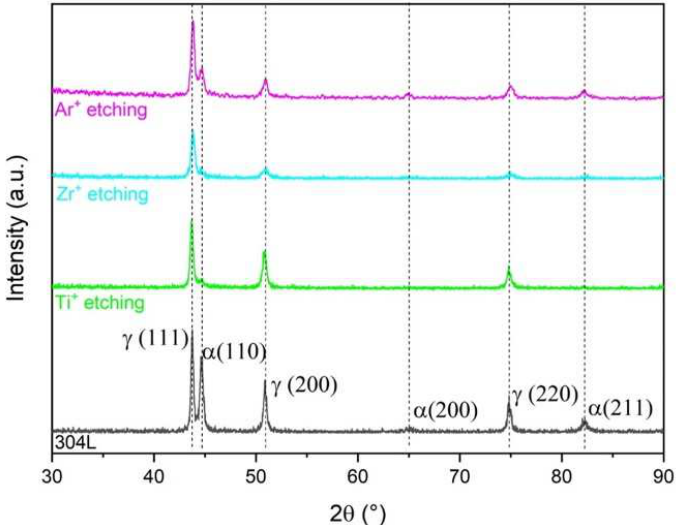
Figure 2. GAXRD patterns at 0.5° incident angle for the raw and etched (Ar + , Zr + and Ti + ) 304L samples. 304L